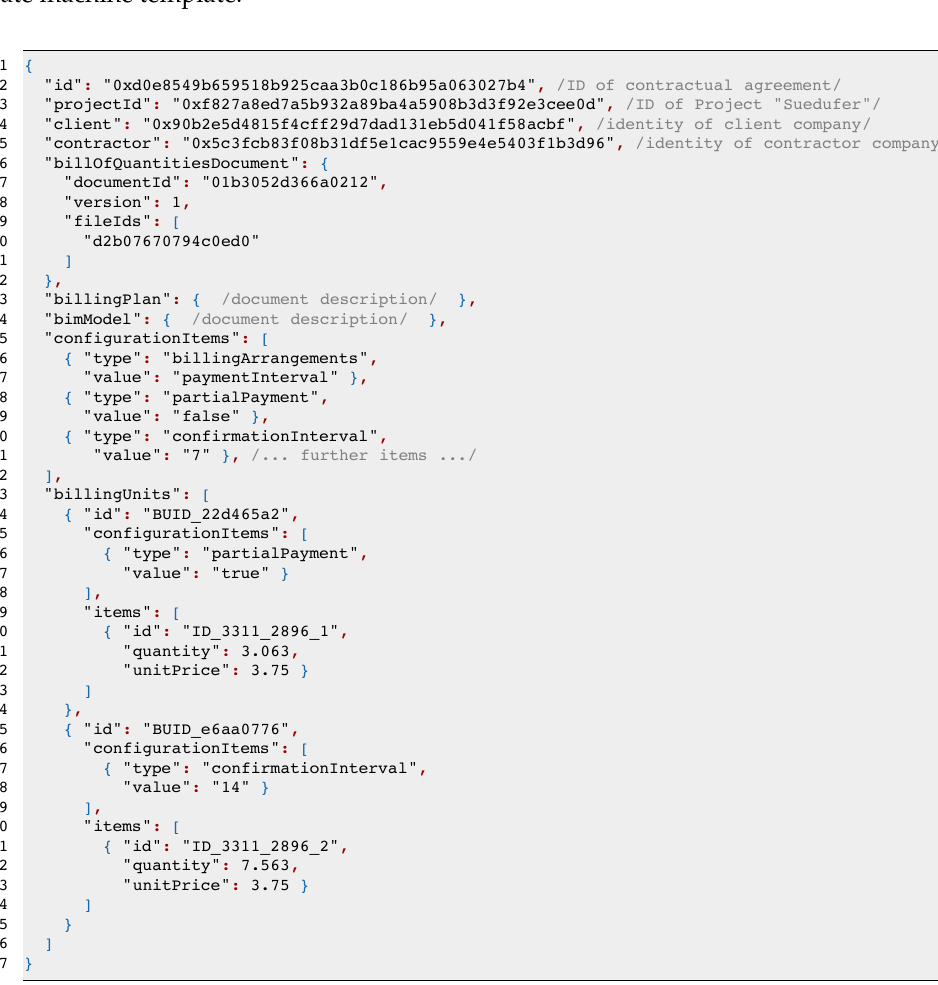
Figure 4. Example of a smart contract configuration, which is sent to the generator via the REST